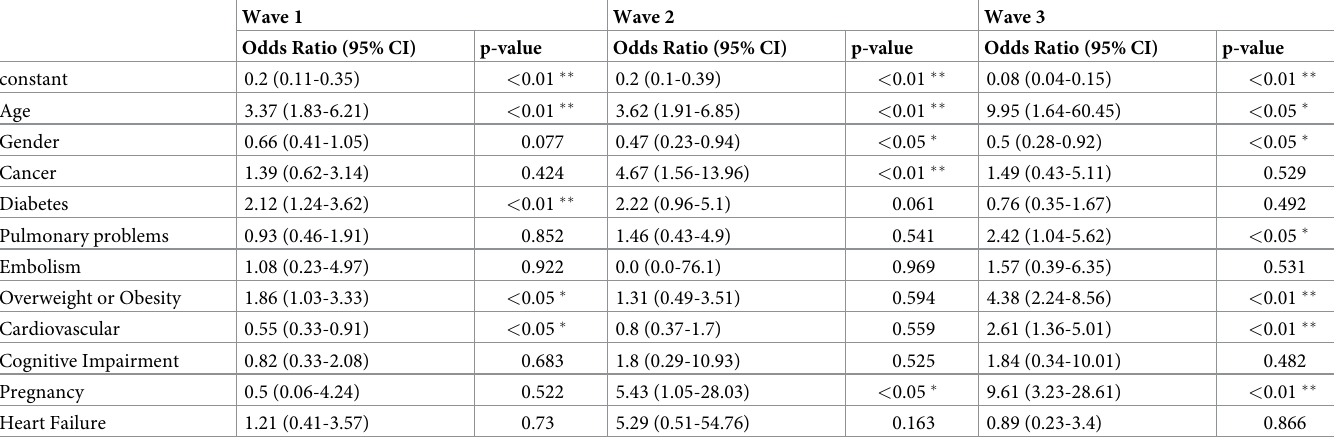
Table 3. Results of multivariate logistic regression